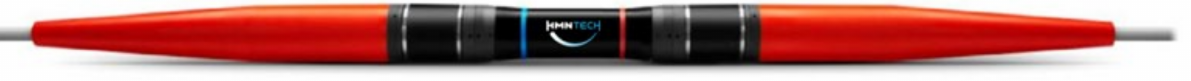
Figure 17. Fifth-generation remote optical pumping amplifier [12].